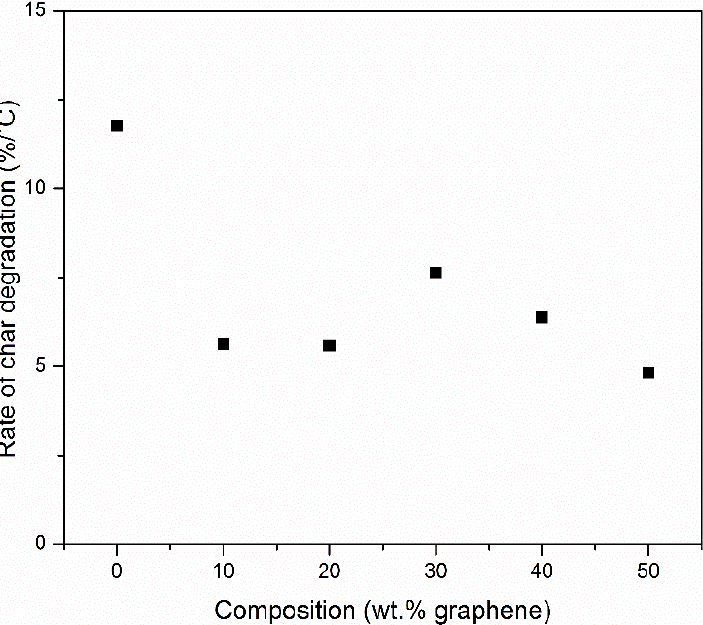
Figure 11. Rate of char degradation as a function of graphene composition in the nanocomposites Graphene (in air; β = 30 °C/min).